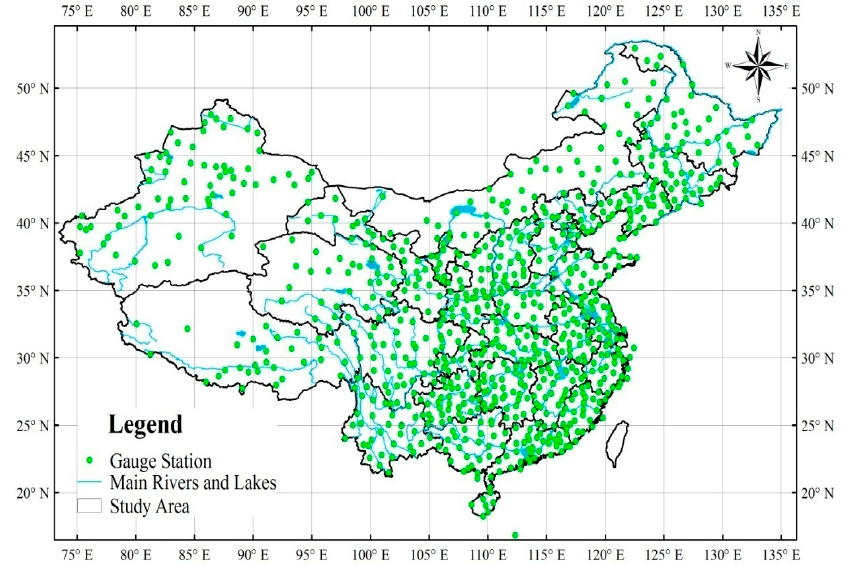
Figure 1. Distribution of rain gauge stations over the Chinese mainland used in this study.